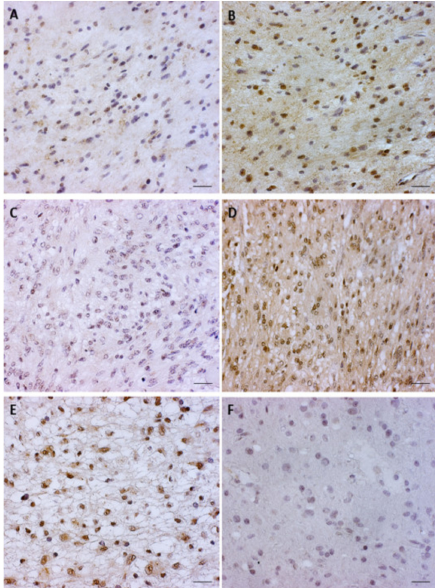
Figure 5. Characteristic immunohistochemical staining of active pGSK3 β -Y216 and inactive pGSK3 β - S9 protein in astrocytoma. ( A ) astrocytic brain tumor grade II with unmethylated GSK3 β promoter showing weak cytoplasmic staining of pGSK3 β -S9; ( B ) same astrocytic brain tumor grade II with unmethylated GSK3 β promoter showing strong cytoplasmic and nuclear staining of pGSK3 β -Y216; ( C ) glioblastoma (grade IV) with unmethylated GSK3 β promoter showing lack of cytoplasmic staining of pGSK3 β -S9; ( D ) same glioblastoma with unmethylated GSK3 β promoter showing strong cyto- plasmic and nuclear staining of pGSK3 β -Y216; ( E ) glioblastoma (grade IV) with methylated GSK3 β promoter showing moderate cytoplasmic and strong nuclear staining of pGSK3 β -S9; ( F ) glioblastoma (grade IV) with methylated GSK3 β promoter showing weak cytoplasmic staining of pGSK3 β -Y216. Scale bar 50 µ